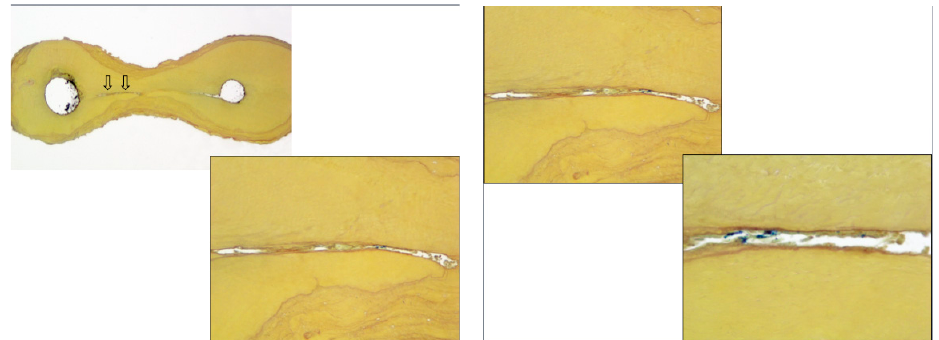
Figure 4. Histological section of the isthmus area between two canals in a mandibular molar, stained by Taylor modified Brown and Brenn stain (16× and 100×) showing the presence of numerous bacterial masses with tissue. A higher magnification (100× and 400×) reveals the presence of residual bacteria and debris in the communications between canals after cleaning and instrumentation of root canal systems. This is the existing challenge in root canal treatment (Courtesy: Dr. Domenico Ricucci, Italy).